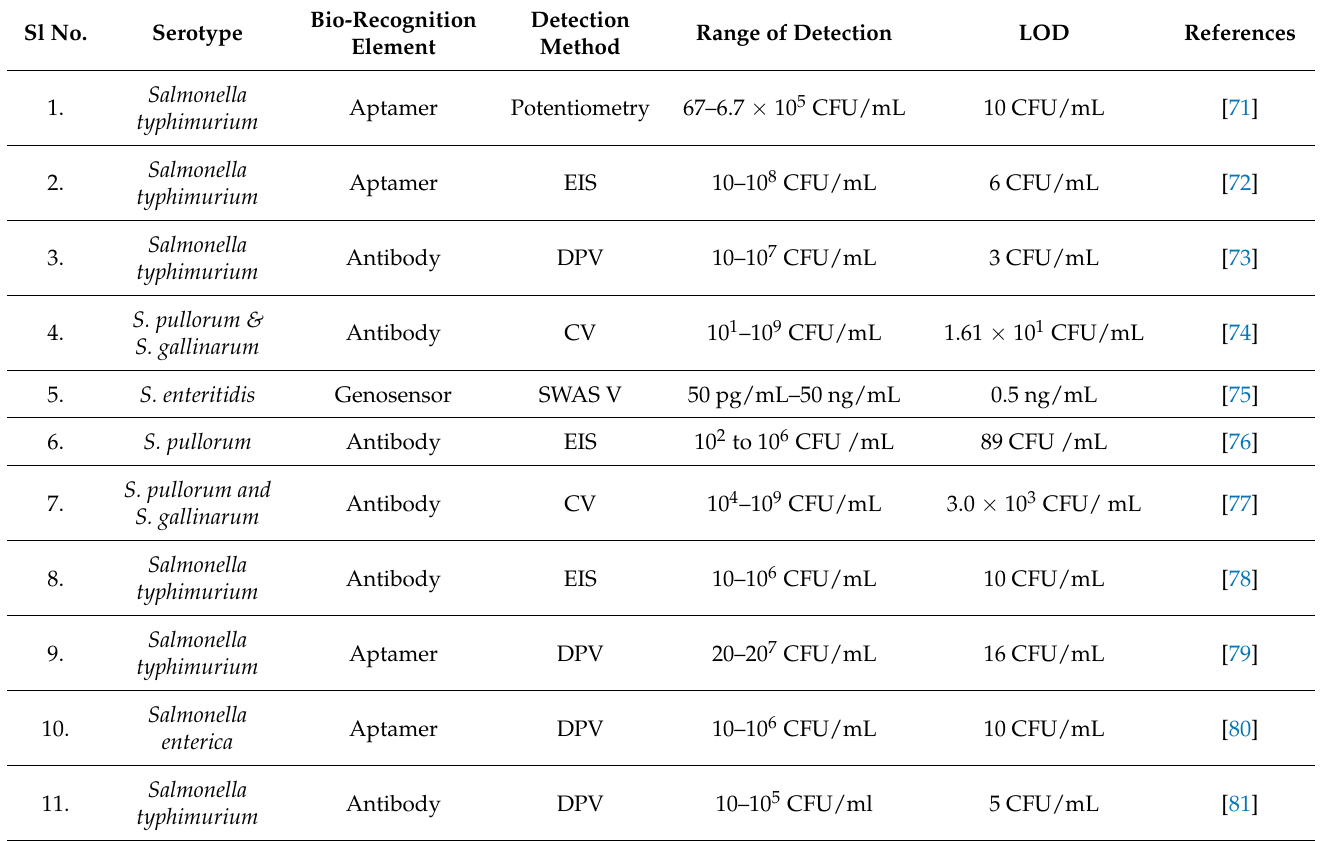
Table 1. Electrochemical biosensors for the detection of Salmonella